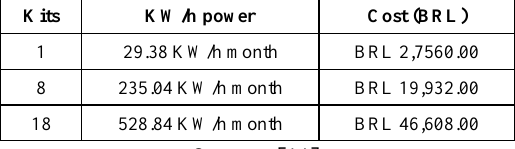
Table 4: Cost of equipment without installation price.